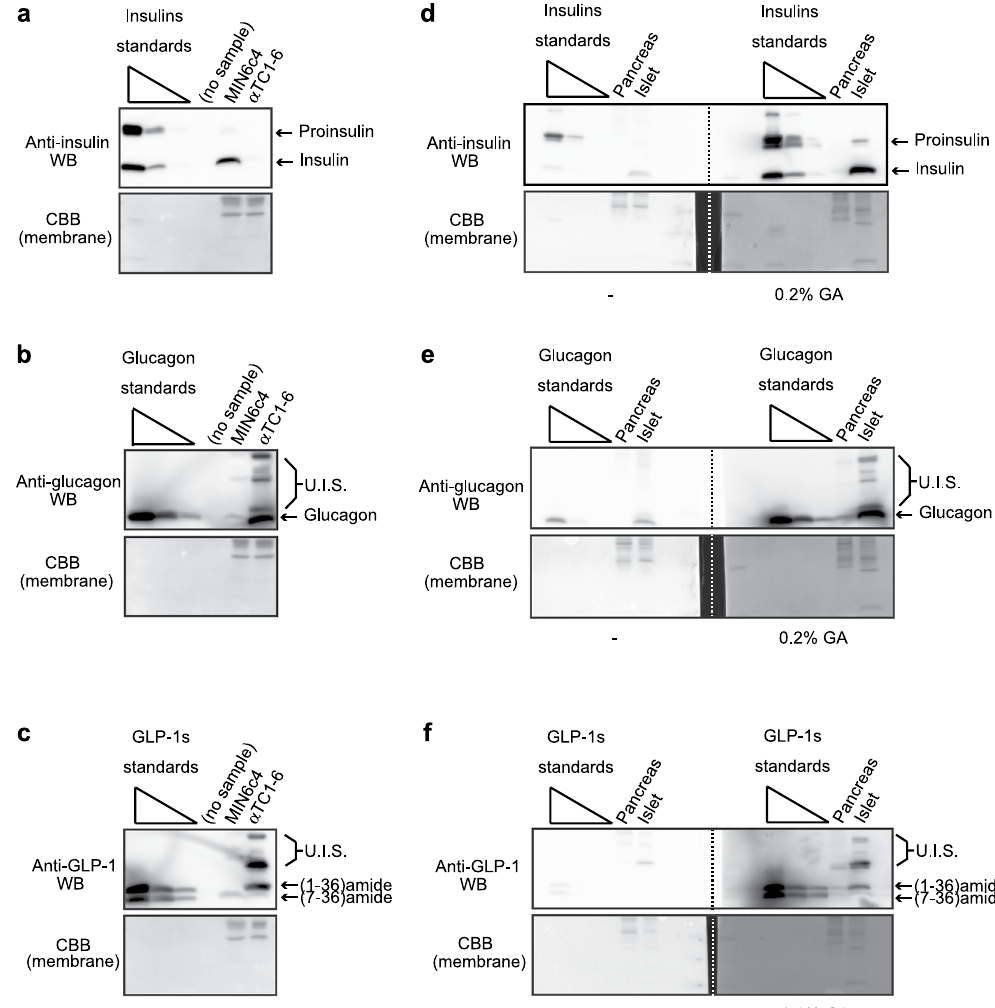
Figure 7. Application of the improved method for cell lines, pancreas, or islet samples shows versatility of the method. ( a ) Insulins, ( b ) glucagon, and ( c ) GLP-1 proteins in MIN6c4 and α TC1-6 cell lysates (5 μ g) were detected using the improved WB (fixation, 0.2% GA). The loaded standards were as follows: proinsulin/insulin, 51.7 to 0.5 pmol (each 1/10 dilution, 3 points); glucagon, 287.1 to 2.9 pmol (each 1/10 dilution, 3 points); and GLP-1 (1-36) amide/GLP-1 (7-36) amide, 30.3 to 0.3 pmol (each 1/10 dilution, 3 points). CBB staining of the blotted membrane was performed to ensure appropriate loading. ( d ) Insulins, ( e ) glucagon, and ( f ) GLP-1s in whole mouse pancreas and islets were analyzed by WB with or without the additional steps. The loaded standards were as follows: proinsulin/insulin, 51.7 to 0.5 pmol (each 1/10 dilution, 3 points); glucagon, 287.1 to 2.9 pmol (each 1/10 dilution, 3 points); and GLP-1 (1-36) amide/GLP-1 (7-36) amide, 91.0 to 0.9 pmol (each 1/10 dilution, 3 points). CBB staining of the blotted membrane was performed to ensure appropriate loading. The WB images in each sub-part of the figure were captured at one time. U.I.S., unidentified